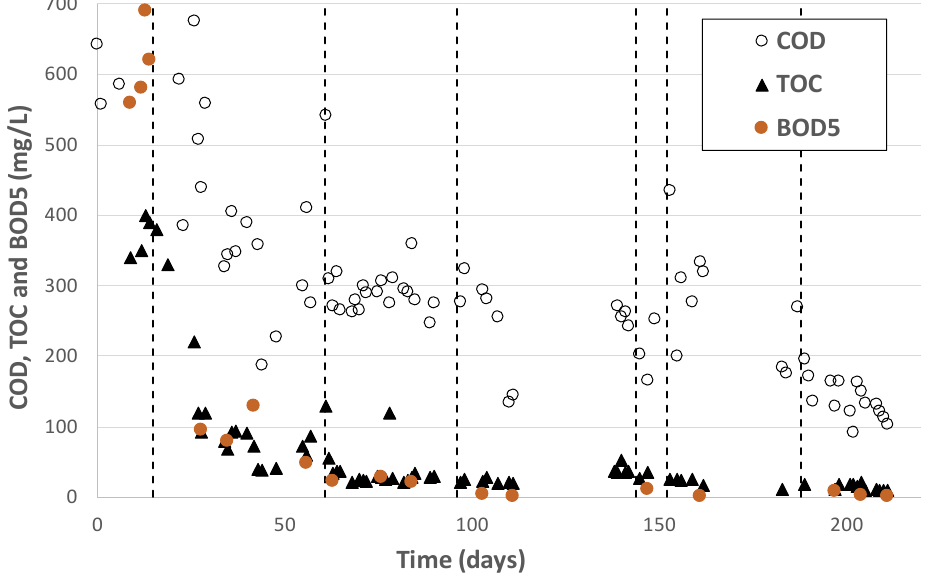
Figure 14. Residual soluble COD, TOC and DBO5 downstream MBBR and gravity separator.